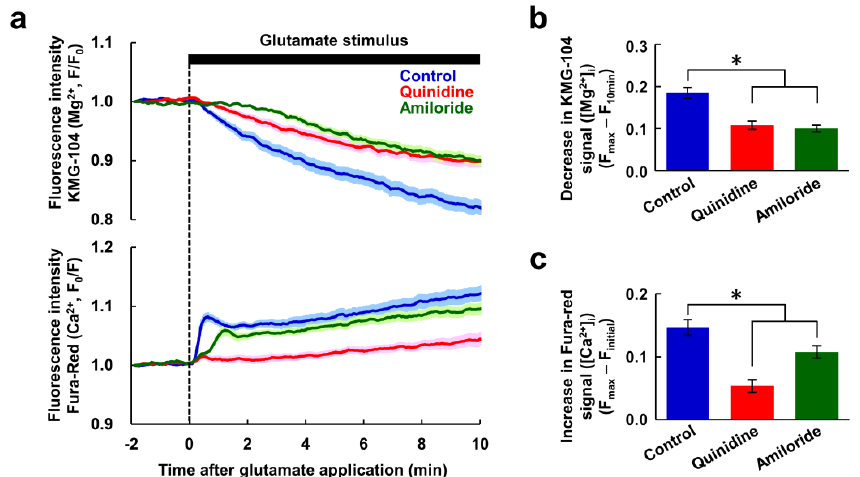
Figure 3. The Mg 2+ and Ca 2+ increases were not required for Mg 2+ extrusion. ( a ) Time-courses of [Mg 2+ ] i (upper) and [Ca 2+ ] i (bottom) response to glutamate stimulus in nominally Ca 2+ -free conditions in the presence or absence of inhibitor (blue: control, n = 60 cells; red: with quinidine at 200 μM, n = 52 cells; green: with amiloride at 500 μM, n = 54 cells, from 5 replicates each). Data are presented as the average (solid line) ± SEM (shaded area). average (solid line) ± SEM (shaded area). Comparison of decrease in KMG-104 signal ([Mg 2 + ] i ) ( b ) and Comparison of decrease in KMG-104 signal ([Mg 2+ ] i ) ( b ) and increase in Fura-red signal ([Ca 2+ ] i ) ( c ) at 10 min increase in Fura-red signal ([Ca 2 + ] i ) ( c ) at 10 min after application of the glutamate stimulus extracted after application of the glutamate stimulus extracted from the data shown in ( a ). Error bars indicate SEM. * from the data shown in ( a ). Error bars indicate SEM. * indicates p < 0.05 compared with control by indicates P < 0.05 compared with control by Dunnett’s test. Dunnett’s